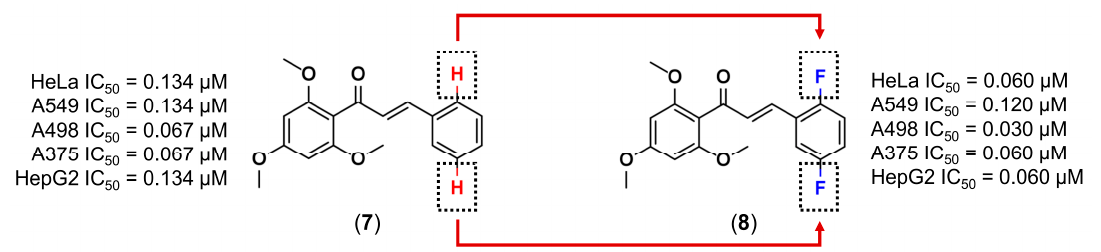
Figure 3. Bioisosterism represented by replacing the hydrogen (red) with a fluorine (blue) [45].